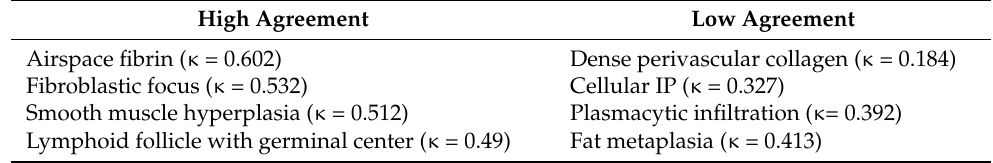
Figure 1. Pathological features. In the scoring items, fibroblastic focus (( A ): HE, ×100) and airspace fibrin (( B ): HE, ×100) showed a high concordance rate among the evaluators. On the contrary, cellular IP (( C ): HE, ×50) and dense perivascular collagen (( D ): HE, ×50) showed a low concordance rate among the evaluators. HE, hematoxylin and eosin. Table 1. Agreement of eight histological parameters.